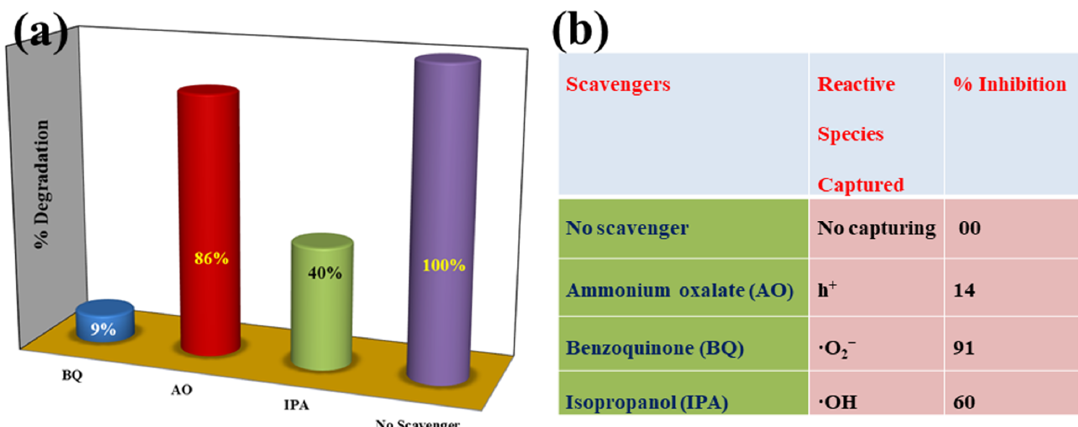
Figure 12. Scavenger effects ( a ) and the capture of reactive species with percentage inhibition ( b ).